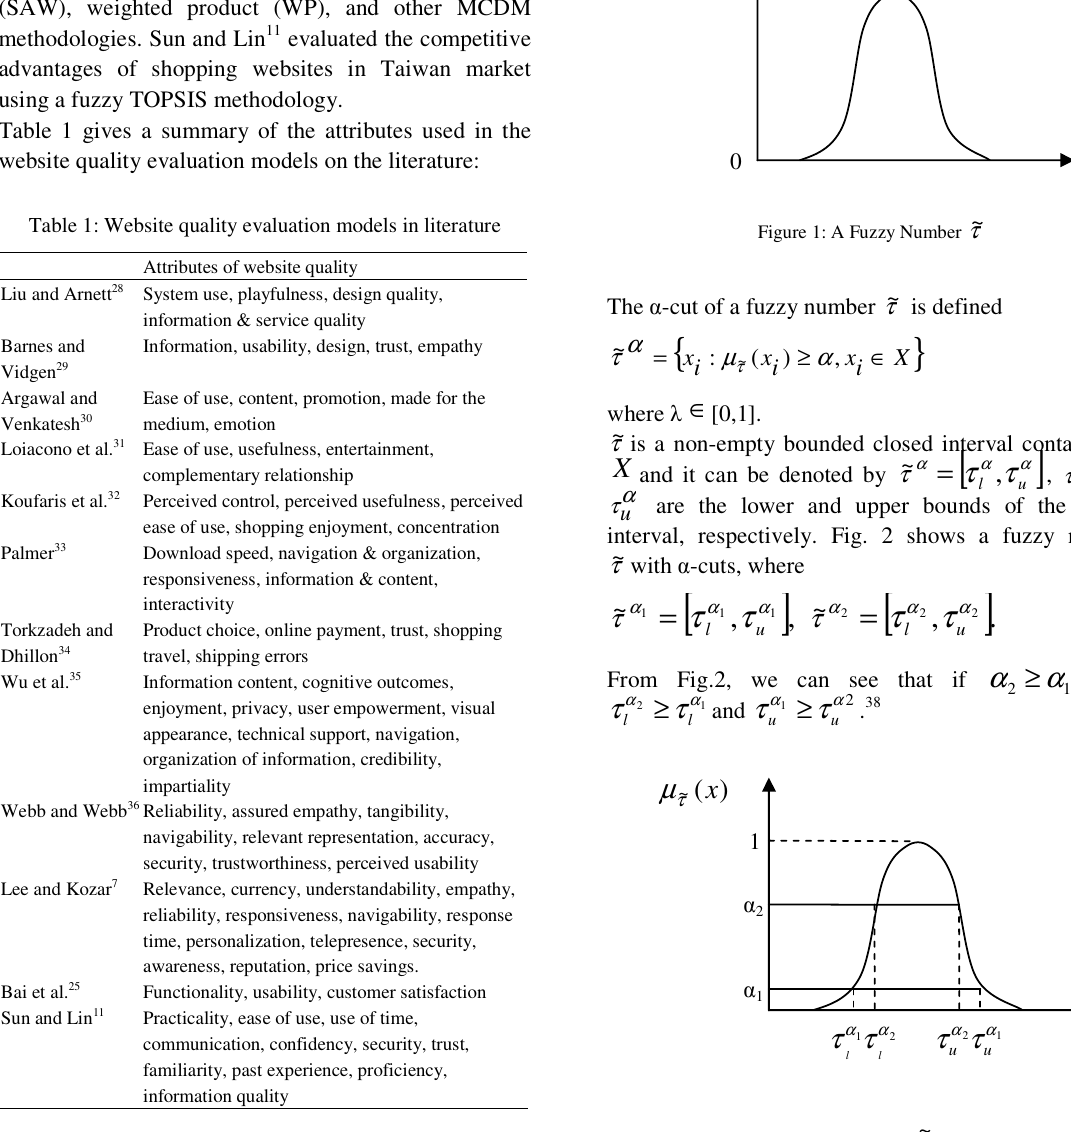
Figure 2: Fuzzy number τ